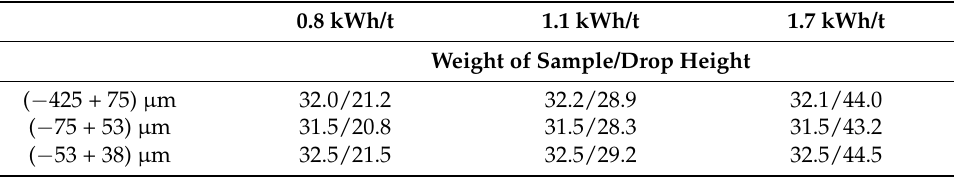
Table 5. Breakage characterization test procedure via drop-weight